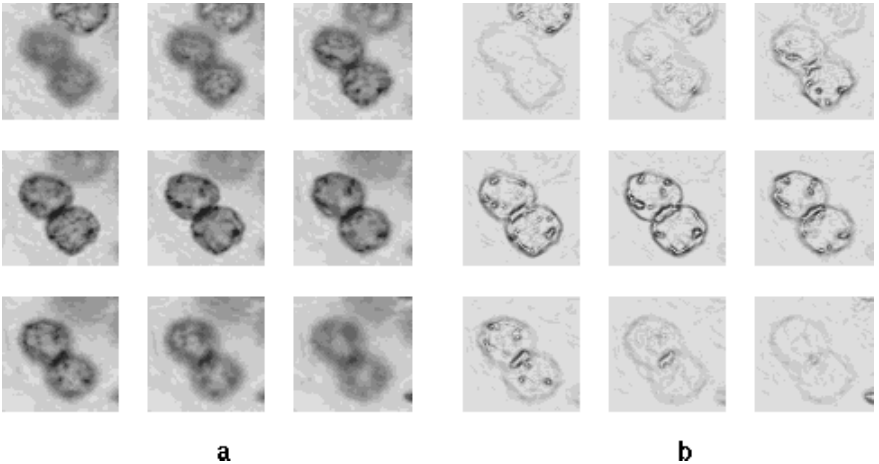
Fig. 3. Sequential z -section images of a partially overlap between two nuclei. (a) Intensity images, (b) gradient images. Size – x,y 13 µ ; z interval 1 µ